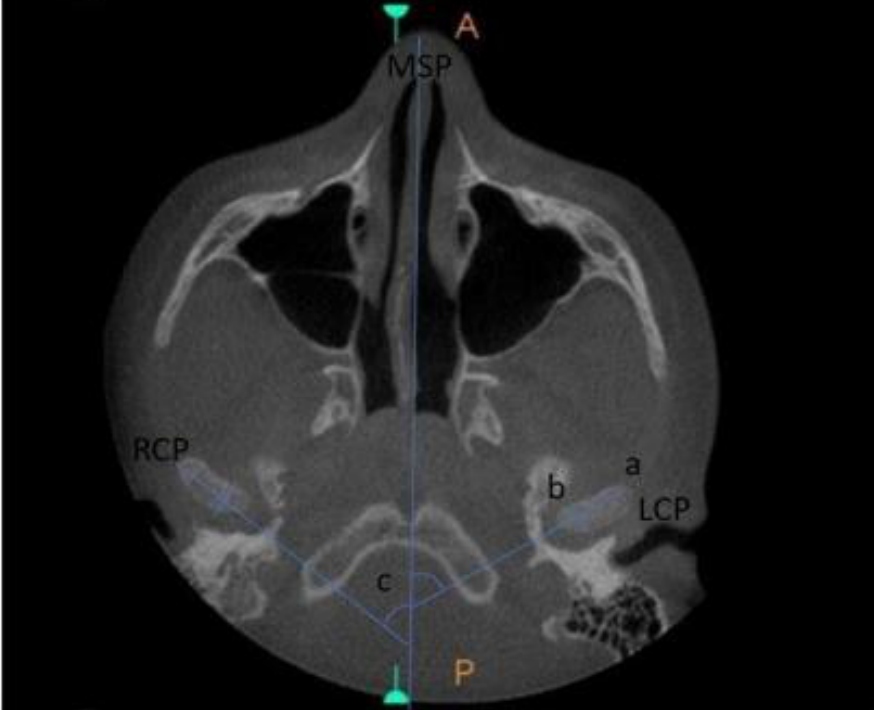
Figure 2. Axial view: a — mediolateral diameter of the condyle; b — antero posterior diameter of the condyle; c — condylar axis angle.